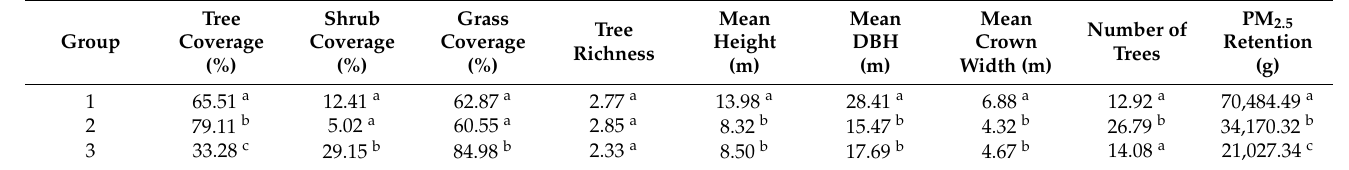
Table 3. Mean value of structural parameters and the corresponding PM 2.5 retention of the three types of green space represented in Groups